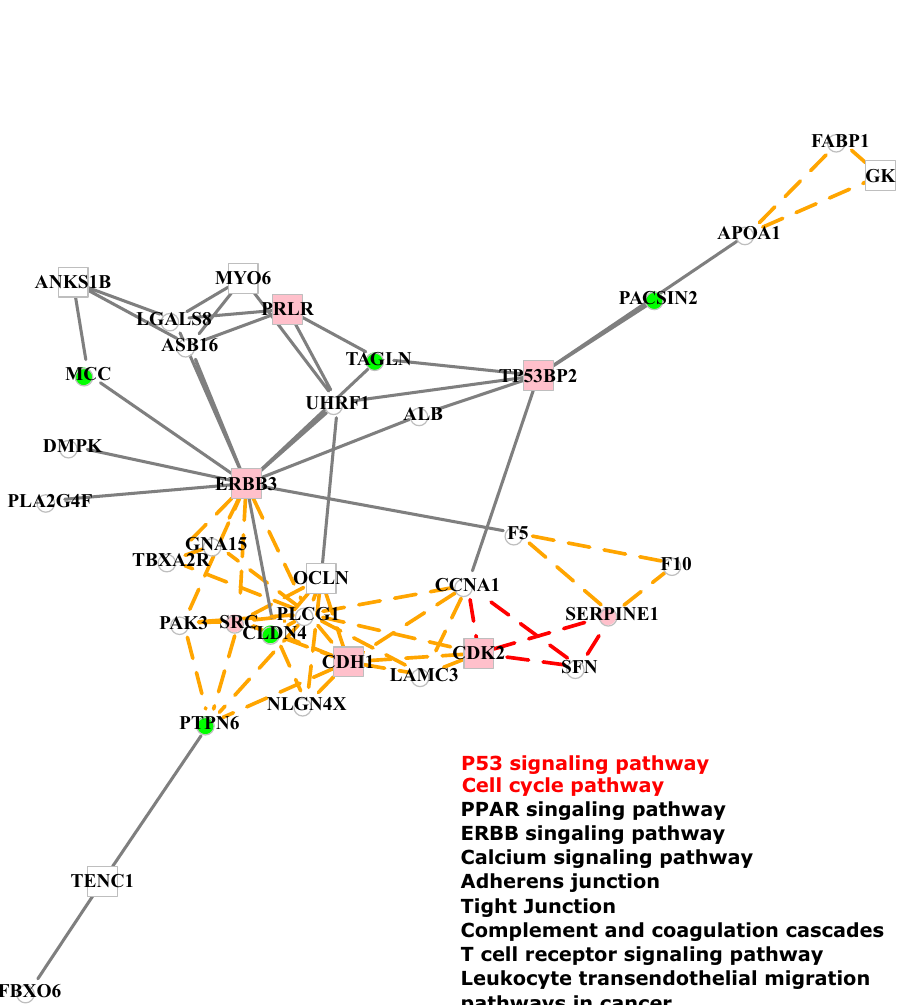
Figure 5. Network analysis of the detected subnetwork 16 in breast cancer. Genes that acted as predictors are represented by circles and responses are represented by squares. Pink nodes denote breast cancer driver genes and green nodes denote cancer genes. A grey line indicates that a Pearson correlation coefficient between a predictor and a response is larger than 0.03. Genes enriched in KEGG breast cancer pathways 49 were connected by red dash lines and the yellow dash lines denote other KEGG pathways. The names for KEGG pathways are shown at the right bottom corner, where the red text indicates the breast cancer specific